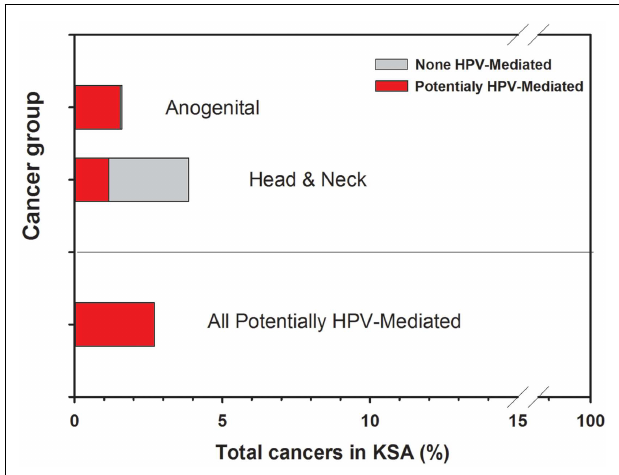
FIGURE 2 | Burden of potentially HPV-mediated cancers in Saudi Arabia .